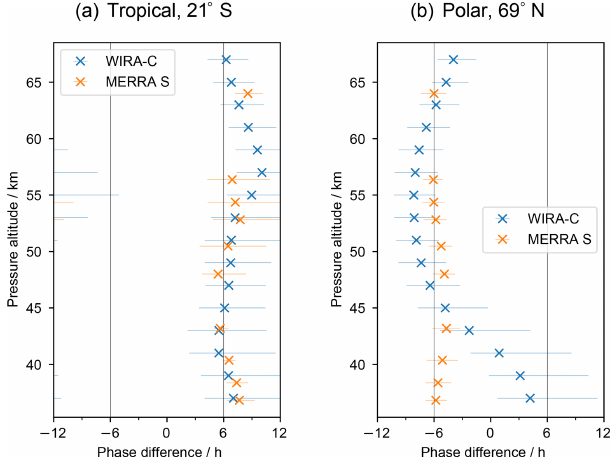
Figure 4. Phase difference between meridional and zonal diurnal wind tide ( (cid:49)φ = φ merid . − φ zonal ) for the tropical and arctic cam- paigns in WIRA-C measurements and the MERRA-2